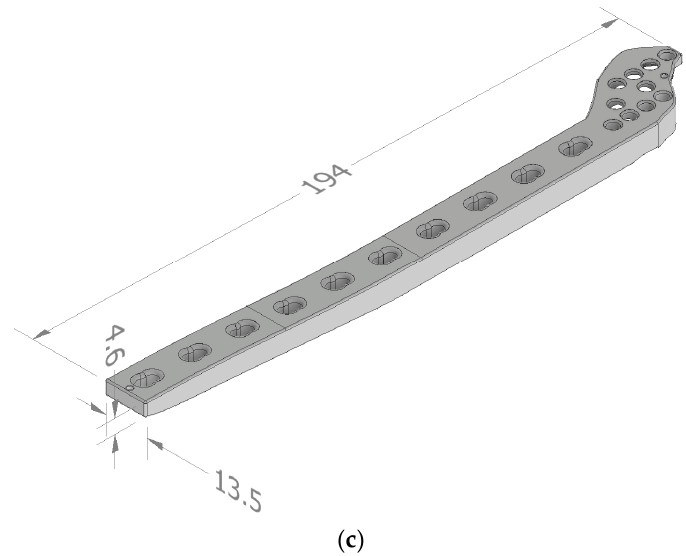
Figure 1. Computer tomography of ( a ) 2D scans and ( b ) 3D bone model and ( c ) initial custom-fit distal tibia fixation plate design, dimensions in mm.